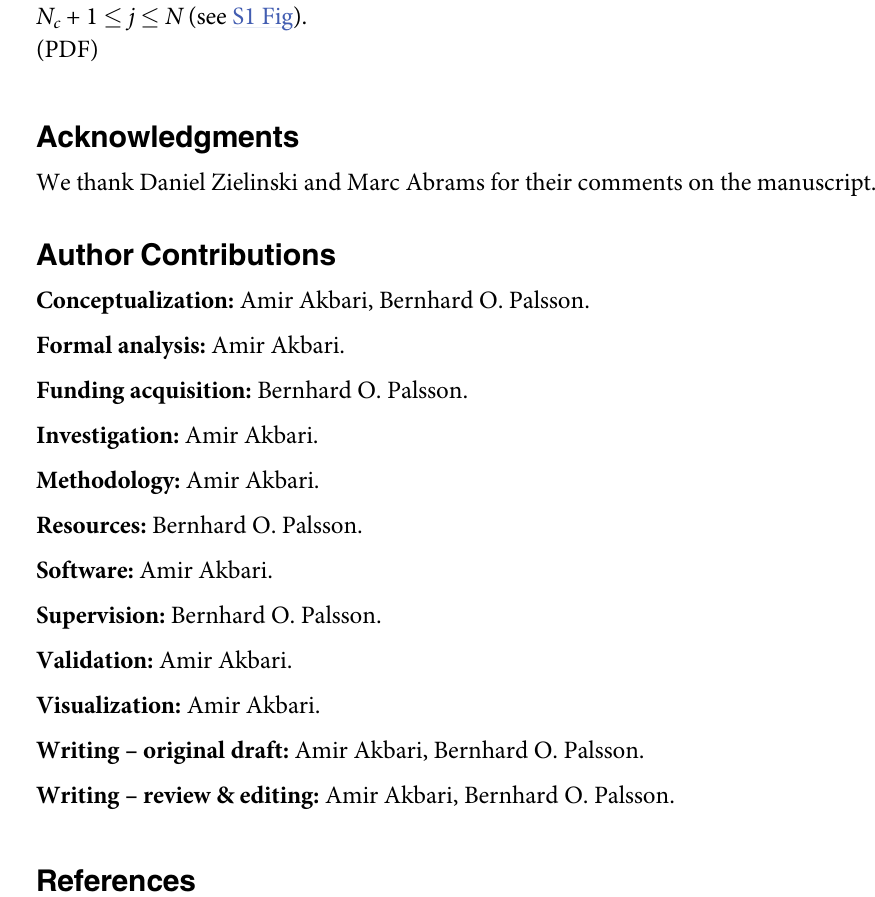
when 1 � j � N and D ^ r ≔ D ^ r when c c m